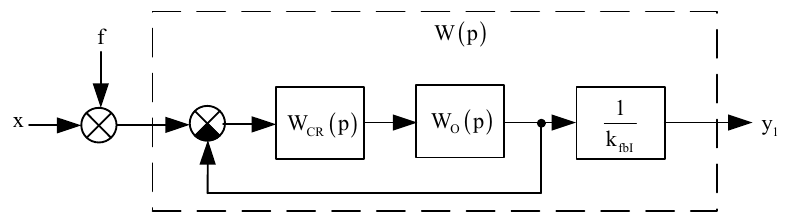
Figure 4. Design structural scheme of the current control channels.